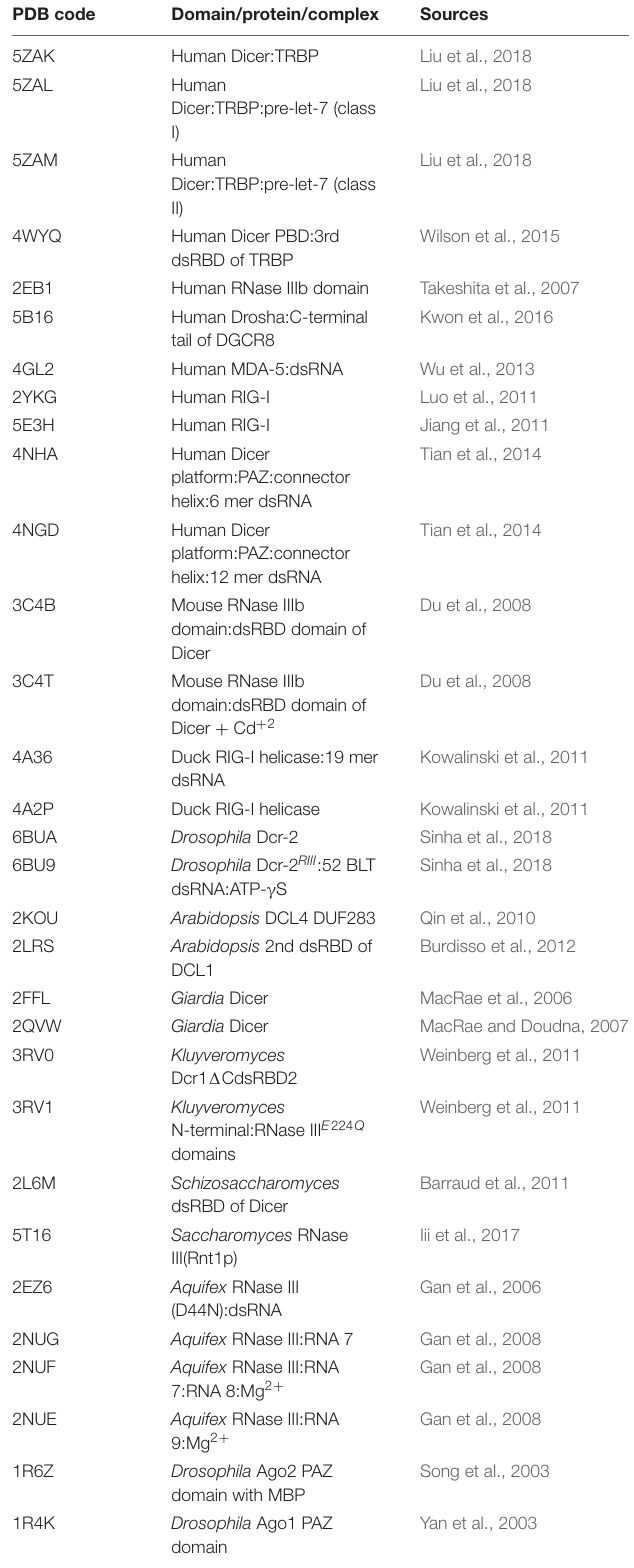
TABLE 1 | RNase III enzymes and Dicer full length and domain structures in the complex without or with dsRNA/substrates along with their PDB ID. PDB code